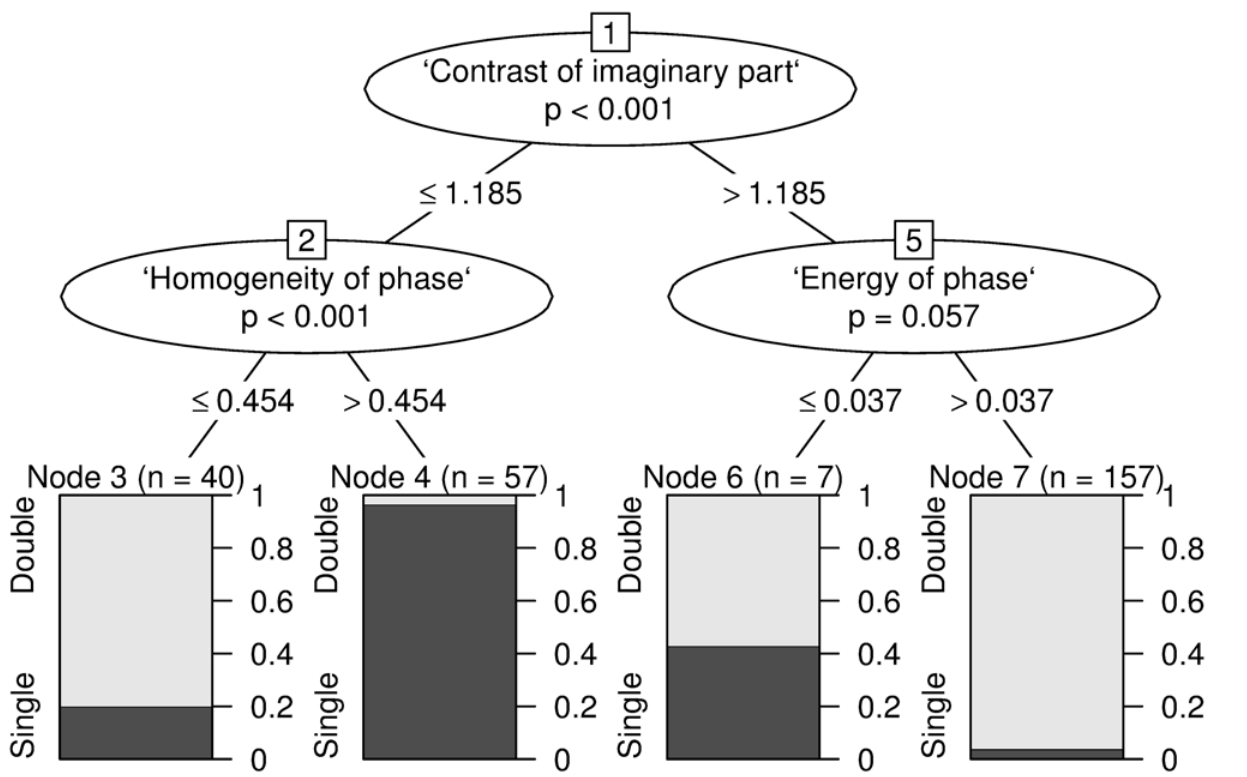
Fig 4. Conditional Inference Tree model of GLCM-based features for detecting